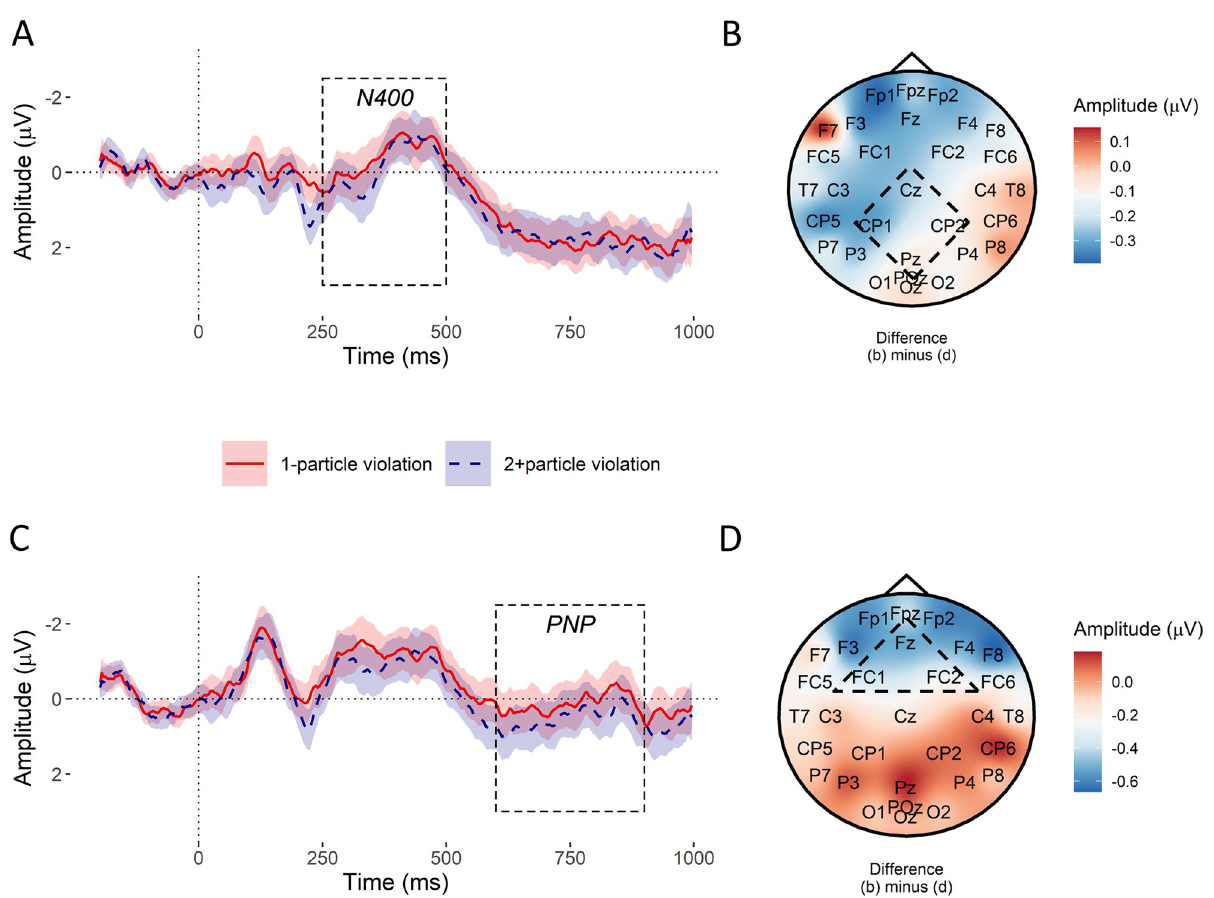
Fig 3. Experiment 2: ERP results. A . ERP waveforms showing an N400 in 1-particle (red) and 2+particle (blue) in the posterior region of interest (Cz, CP1, CP2, Pz). Ribbons show 95% confidence intervals calculated as for Fig 1. The pre-registered time window of the N400 is overlaid. B . The voltage subtraction plot of the difference in amplitude between 1- and 2+particle violations in the N400 time window indicates very little difference in amplitude between the two conditions in the posterior region of interest (dashed square). C . ERP waveforms in anterior (Fz, FC1, FC2) region suggest that the most positive waveform in the pre-registered PNP time window (overlaid) was for 2+particle violations. Ribbons show 95% confidence intervals. D . The voltage subtraction plot of the difference in amplitude between 1- and 2+particle violations in the PNP time window suggests amplitude was more positive for 2+particle violations in the anterior region of interest (dashed